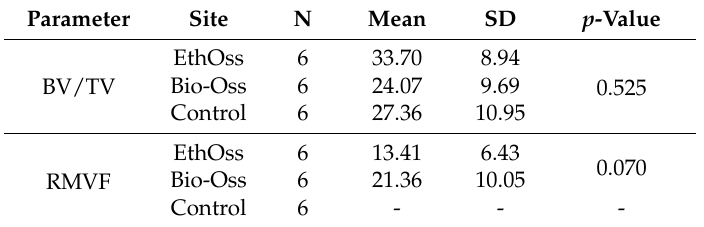
Figure 4. The percentage of new bone (BV/TV) between the three groups, and the percentage of residual graft (RMVF) in sites treated with EthOss and Bio-Oss, after eight weeks of healing. Data are presented as means. The differences between groups were not statistically significant ( p > 0.05). Table 2. Comparison of parameters associate with the newly-formed bone (BV/TV) and the residual grafting material (RMVF). The differences between groups were not statistically significant ( p > 0.05).